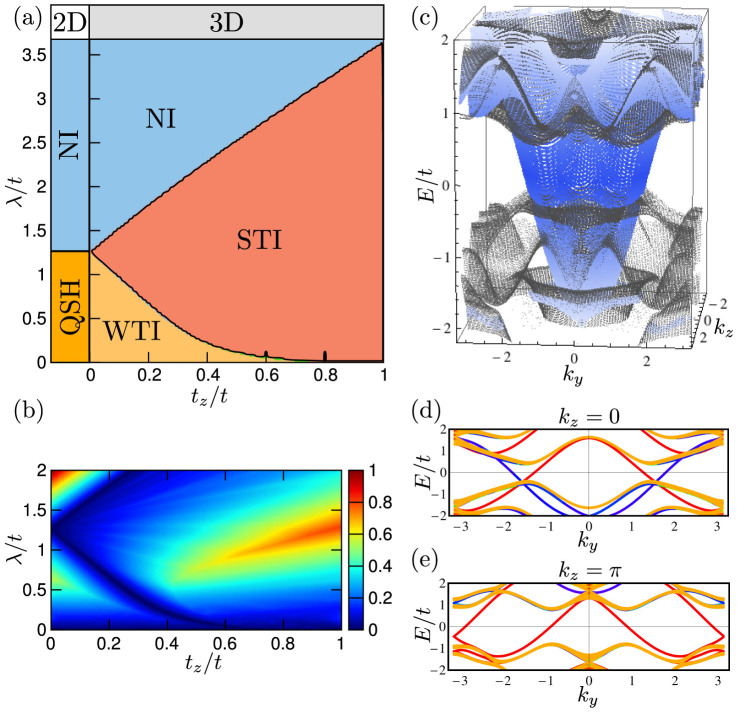
Phase diagram and spectra of the lattice model.(a) 2D–3D crossover phase diagram as a function of layer coupling tz and staggered lattice potential λ. (b) Bulk gap as a function of tz and λ. (c) Surface state spectrum (blue) of the isotropic 3D system tz = t, λ = λc at the x = 0 surface as a function of momenta ky and kz. Bulk states are shown as gray dots. We use open (periodic) boundary conditions along x (y, z). (d–e) One-dimensional cuts of the spectrum for fixed values of kz = 0 and kz = π. Gapless edge states at x = 0 (x = L) edge are shown in blue (red) yielding z0 = 1 and zπ = 0 and thus ν0 = z0 + zπ = 1.